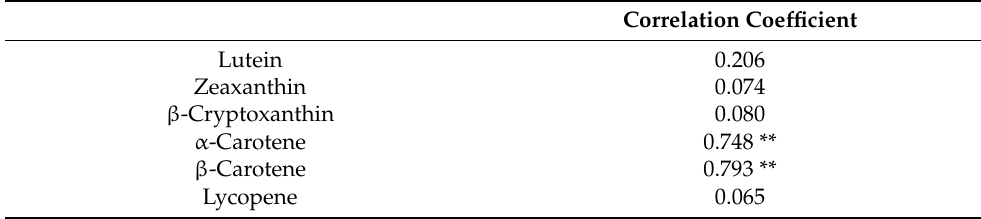
Table 3. Correlation coefficient between the cutaneous and blood carotenoid levels in cross-sectional analysis, day 1 of the pre-ingestion period.